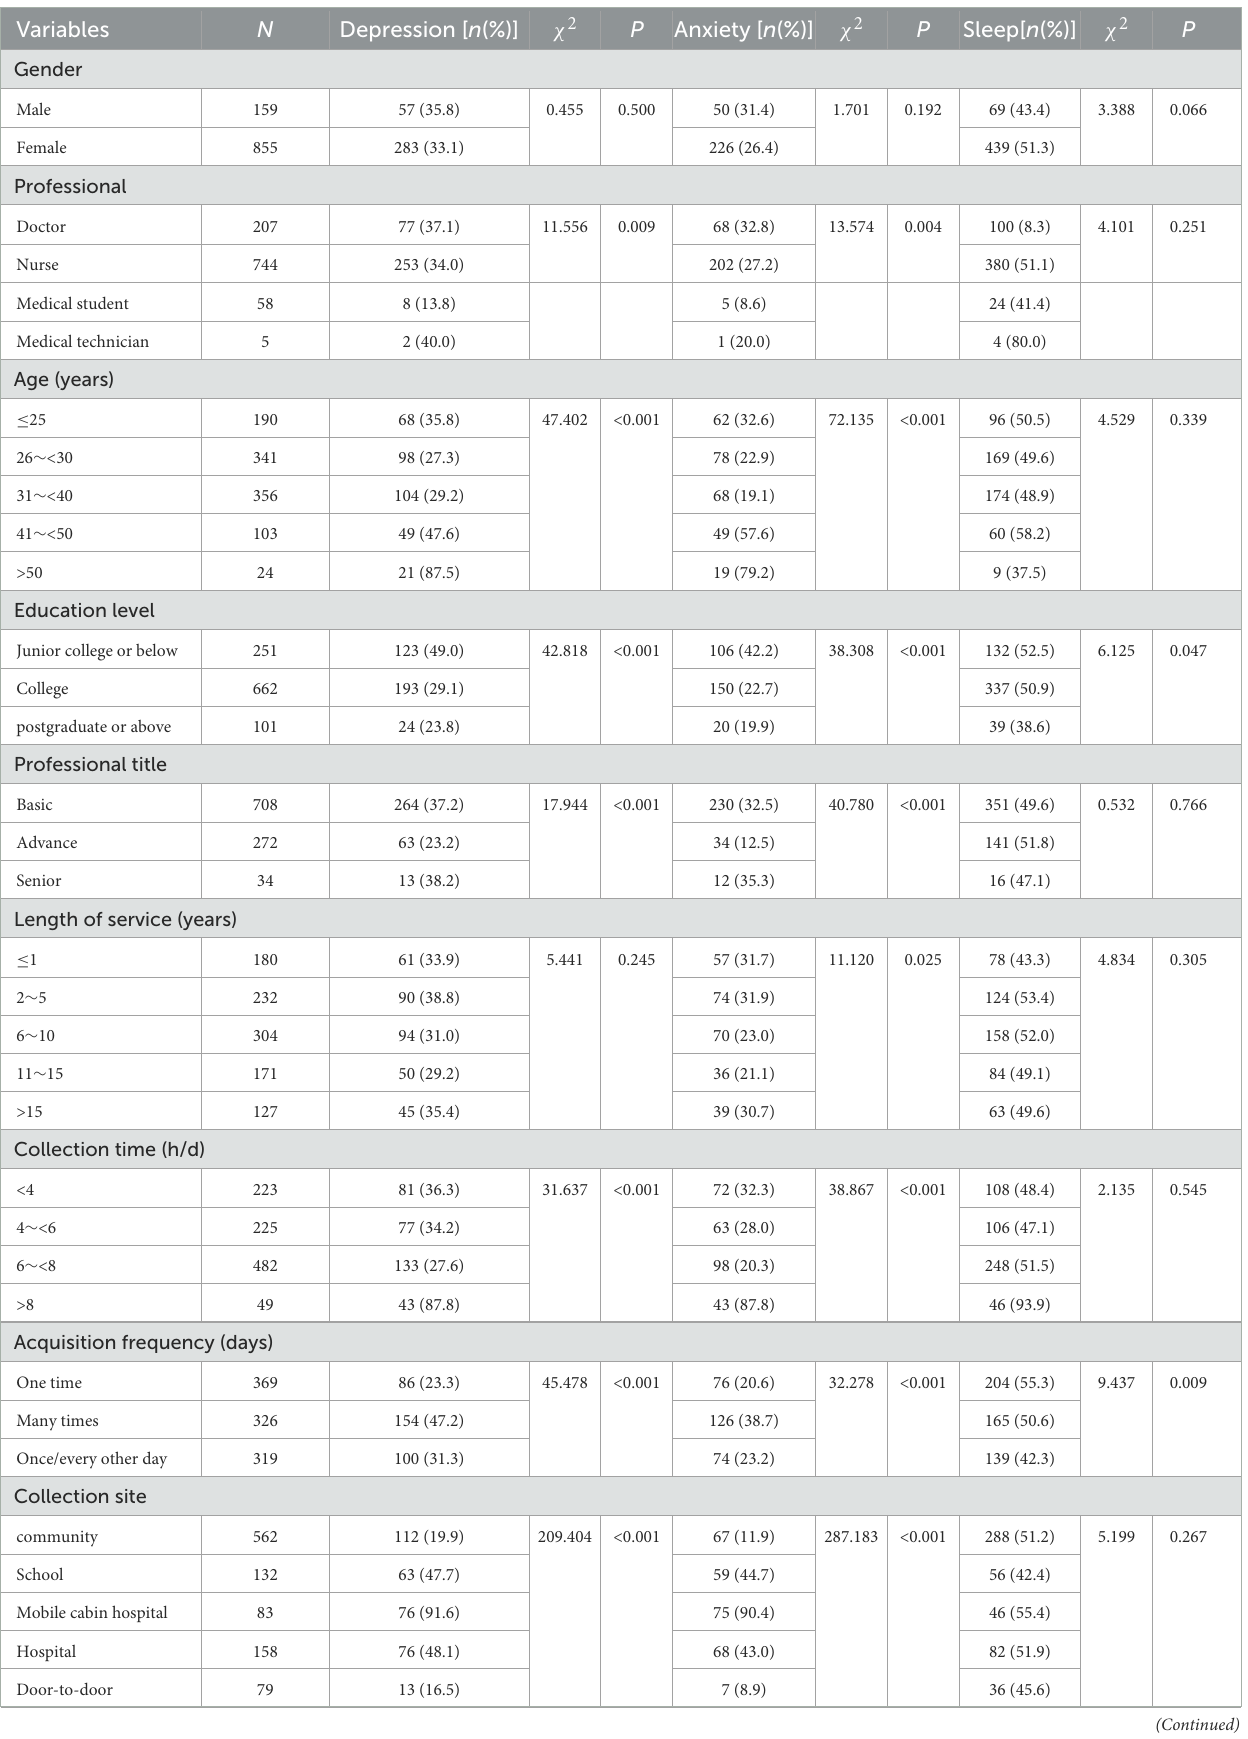
TABLE 4 Monofactor analysis of depression, anxiety and sleep disorder in 1,014 nucleic acid collectors under closed-loop management [ N = 1,014(%)].